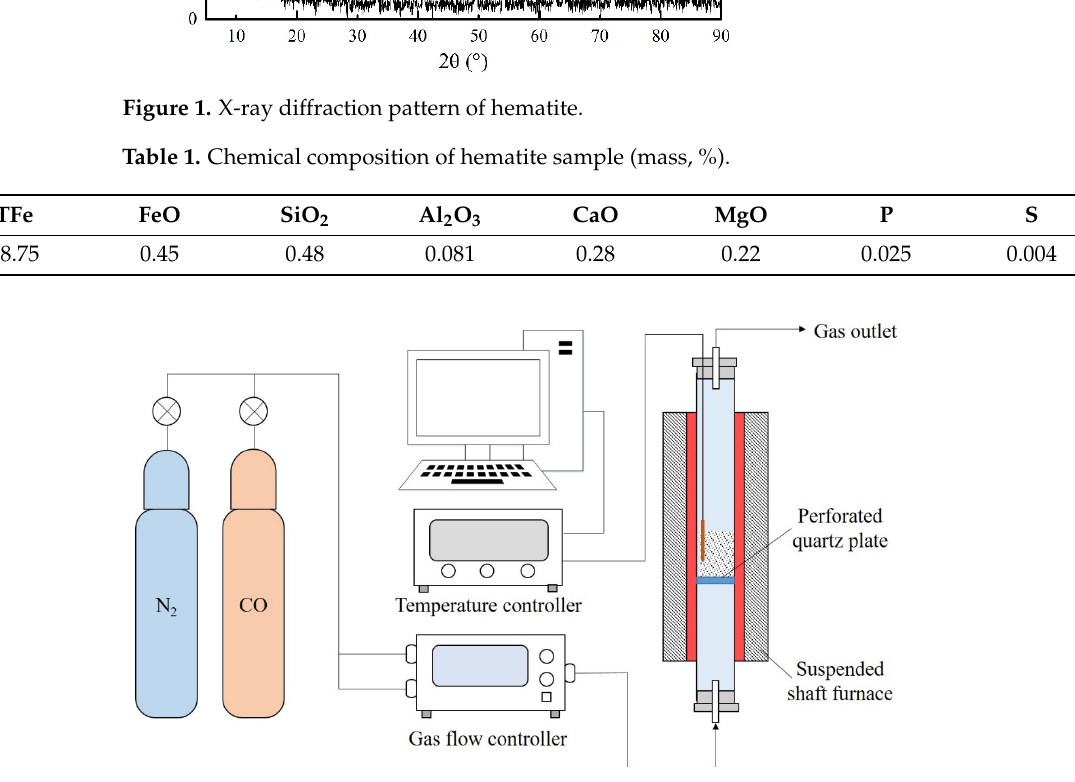
Figure 2. The schematic diagram of the experiment equipment.